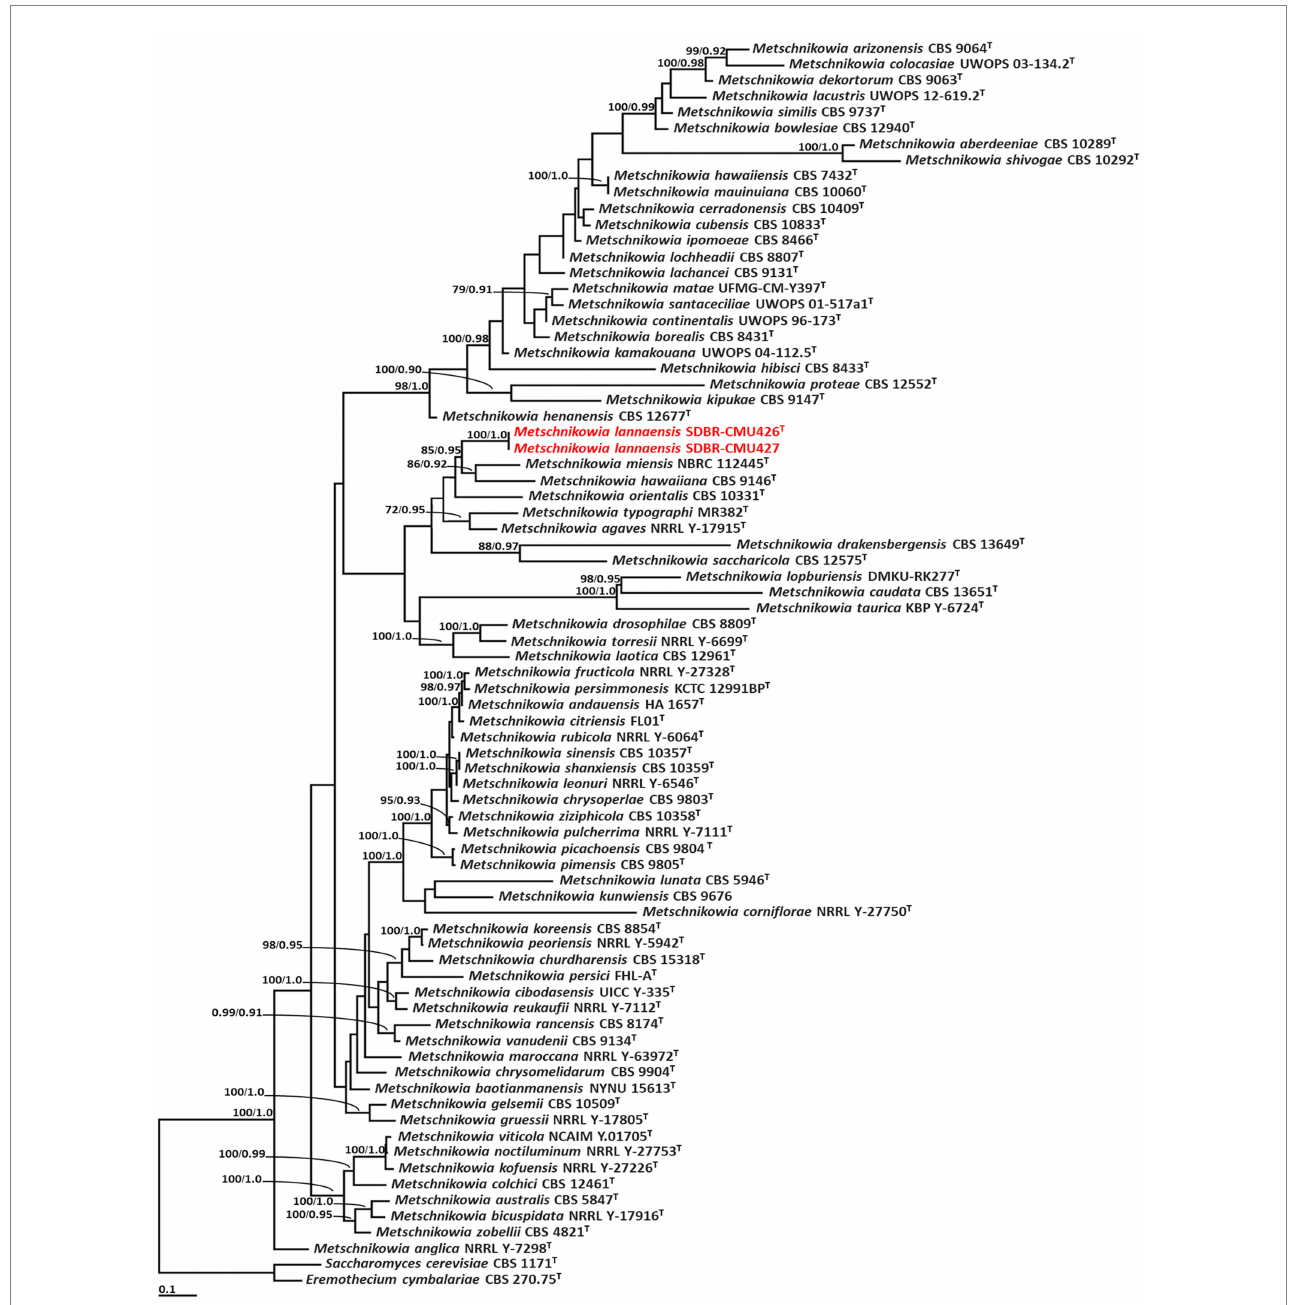
FIGURE 2 Phylogram derived from maximum likelihood analysis of 77 combined sequences of ITS region and D1/D2 domain of Metschnikowia strains. Eremothecium cymbalariae CBS 1171 and Saccharomyces cerevisiae CBS 270.75 were used as the outgroup. The numbers above branches represent bootstrap percentages (left) and Bayesian posterior probabilities (right). Bootstrap values >70% and Bayesian posterior probabilities >0.90 are shown. The scale bar represents the expected number of nucleotide substitutions per site. Sequences obtained from this study are in red. Type species indicated by superscript